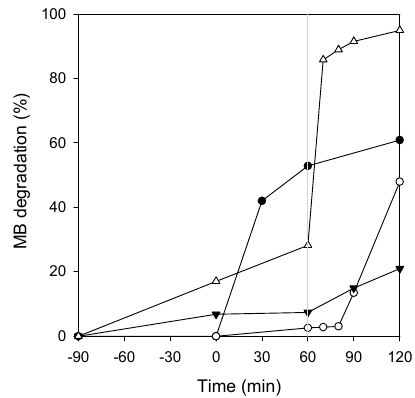
Figure 1. MB (20 mg/L) degradation in time with different catalysts (0.8 g/L): TiO 2 (black circles), Fe 3 O 4 (white circles), Fe 3 O 4 –SiO 2 (black triangles), Fe 3 O 4 –SiO 2 –TiO 2 (white triangles). The vertical grey line represents the moment of the H 2 O 2 addition (3 g/L).